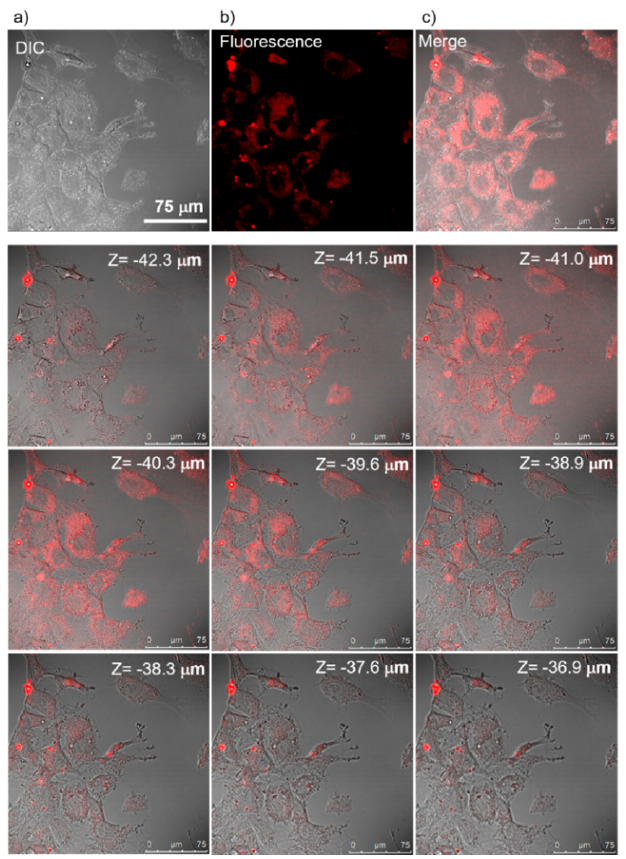
Figure 8. NIH3T3 (Fibroblast) cellular uptake of SiQDs/F127 nanoparticles under confocal microscopy. ( a ) Differential interference contrast (DIC), ( b ) fluorescence, and ( c ) overlap images. Slice scan of NIH3T3 cells under confocal microscopy.